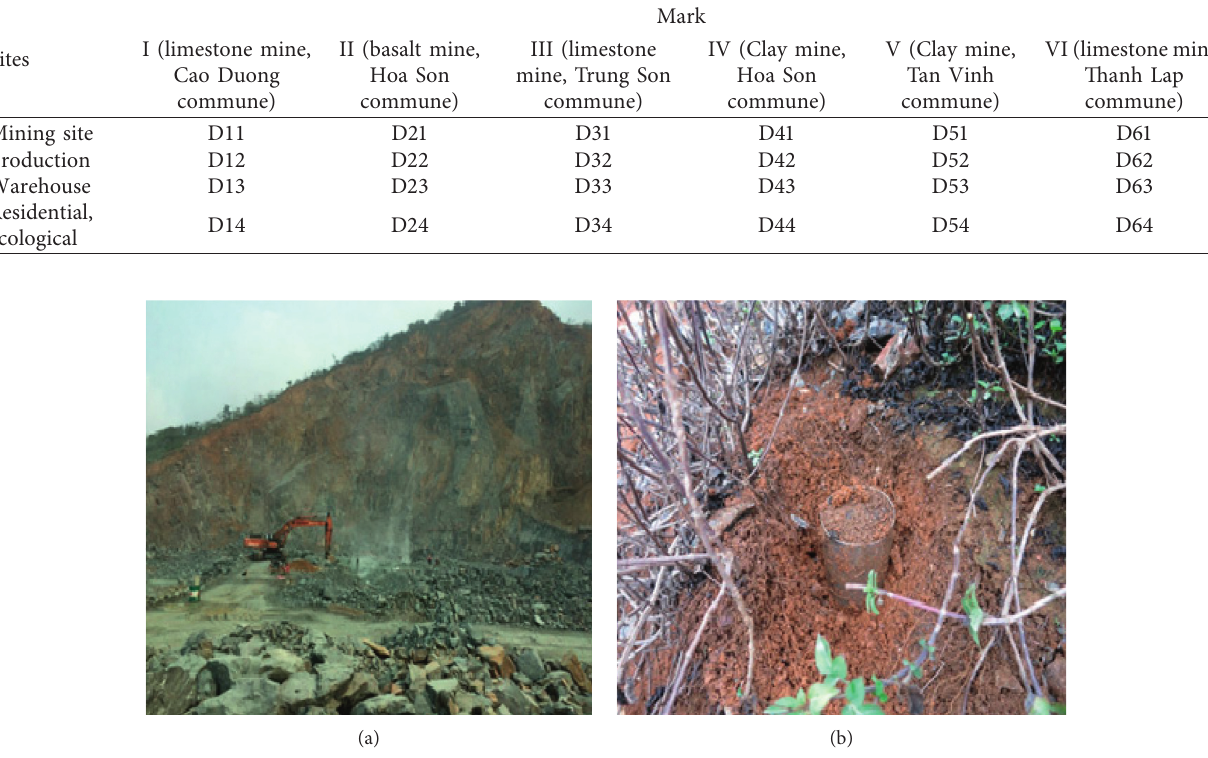
Figure 1: Sampling point in mining site (limestone mine).